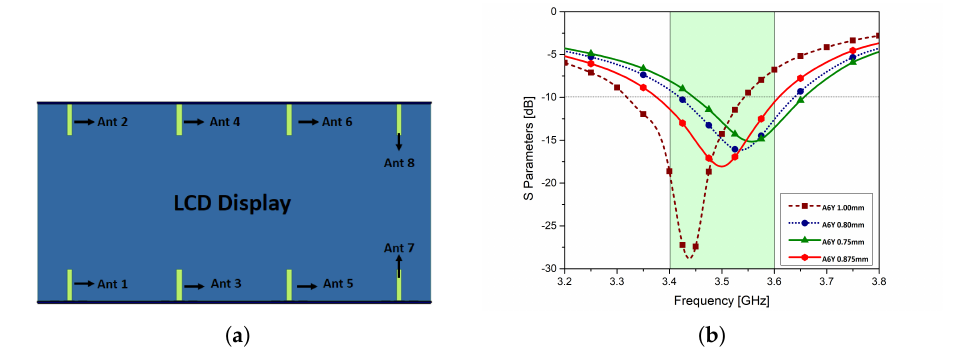
Figure 13. ( a ): Liquid crystal display (LCD) display module with the proposed MIMO antenna system, ( b ): parametric tuning of parameter